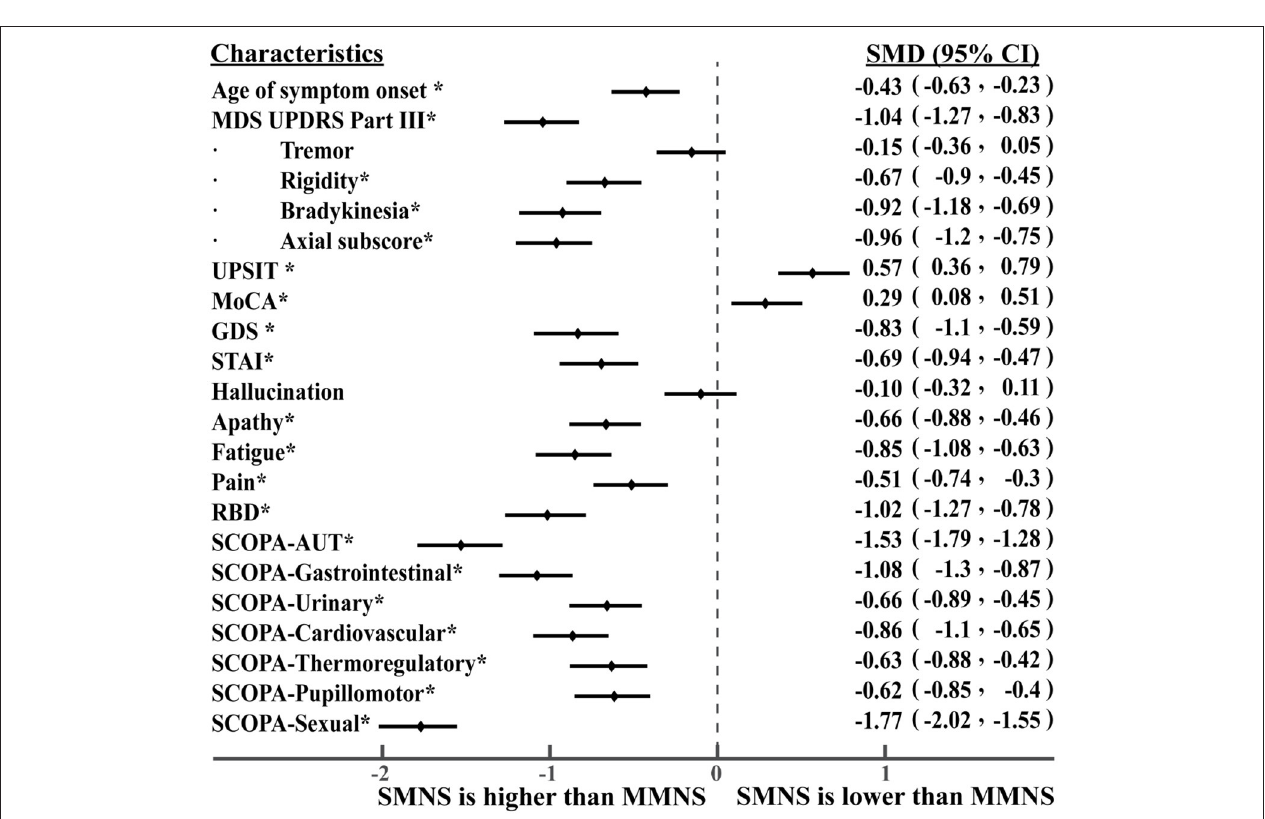
FIGURE 3 | Level of differences in baseline characteristics between PD subtypes. The * symbol indicates statistically significant differences between the two subtypes.